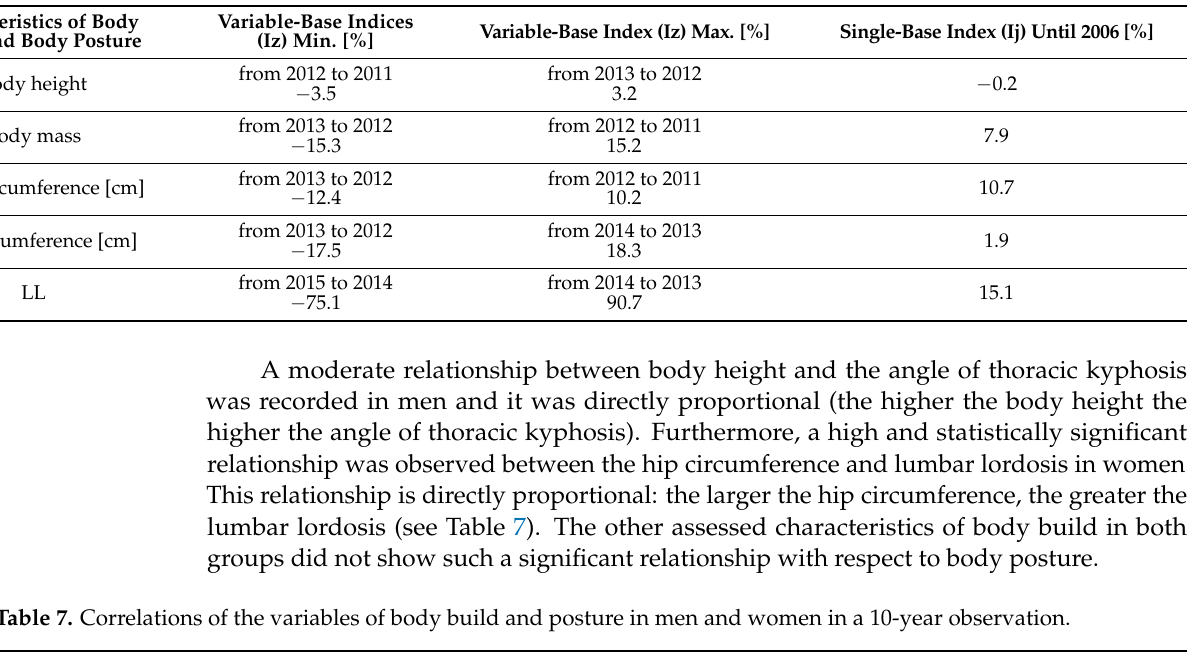
Table 7. Correlations of the variables of body build and posture in men and women in a 10-year observation. Women Men p -Value LordosisVariable Angle of Kyphosis Angle of Lordosis Angle of Kyphosis Angle of Lordosis Height 0.30 ** statistically significant differences